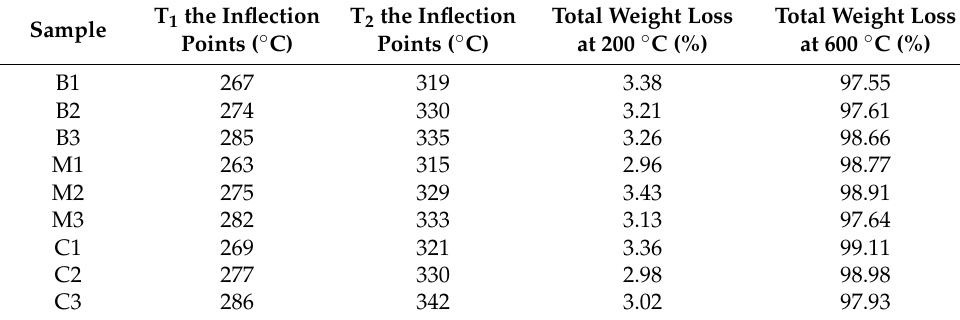
Table 3. The inflection points in the TG